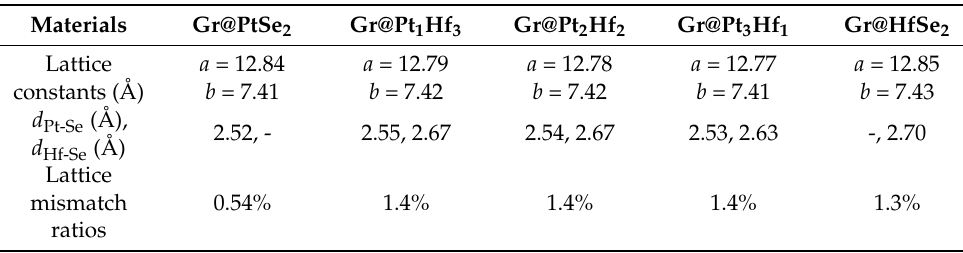
Table 1. The lattice constants (Å), bond lengths (Å) of Pt–Se and Hf–Se, and lattice mismatch ratios of